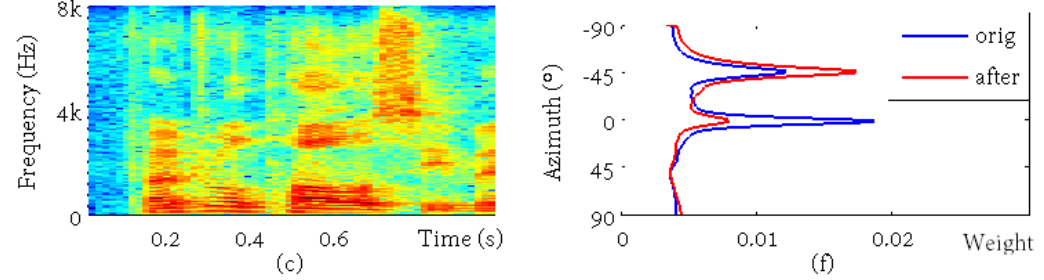
Figure 4. An example for oracle investigation. The sub-figures are, respectively, ( a ) the mixture spectrum, ( b ) the ideal binary mask of the target, ( c ) the reference spectrum, ( d ) the original cWMM weights, ( e ) the cWMM weights after time-frequency selection, and ( f ) the averaged weights before (orig) and after (after) processing.